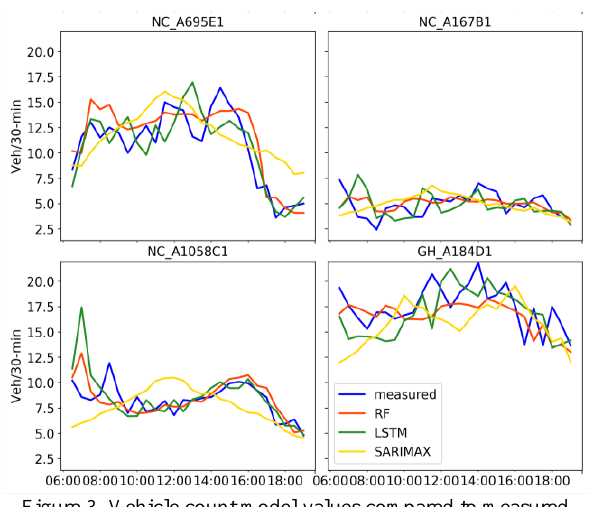
Figure 3. Vehicle count model values compared to measured values for four CCTV locations across the city of Newcastle upon Tyne